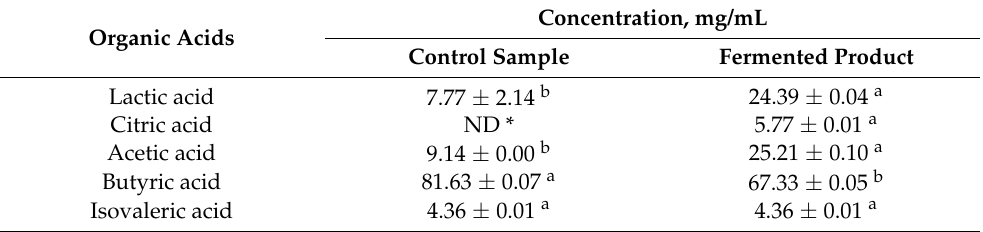
Table 7. The organic acids’ concentrations after the medium fermentation based on bovine colostrum, black tea and sugar with milk kefir grains and freeze-dried kombucha membrane starter culture, under optimized conditions. Concentration, mg/mL Organic Acids Control Sample Fermented Product Lactic